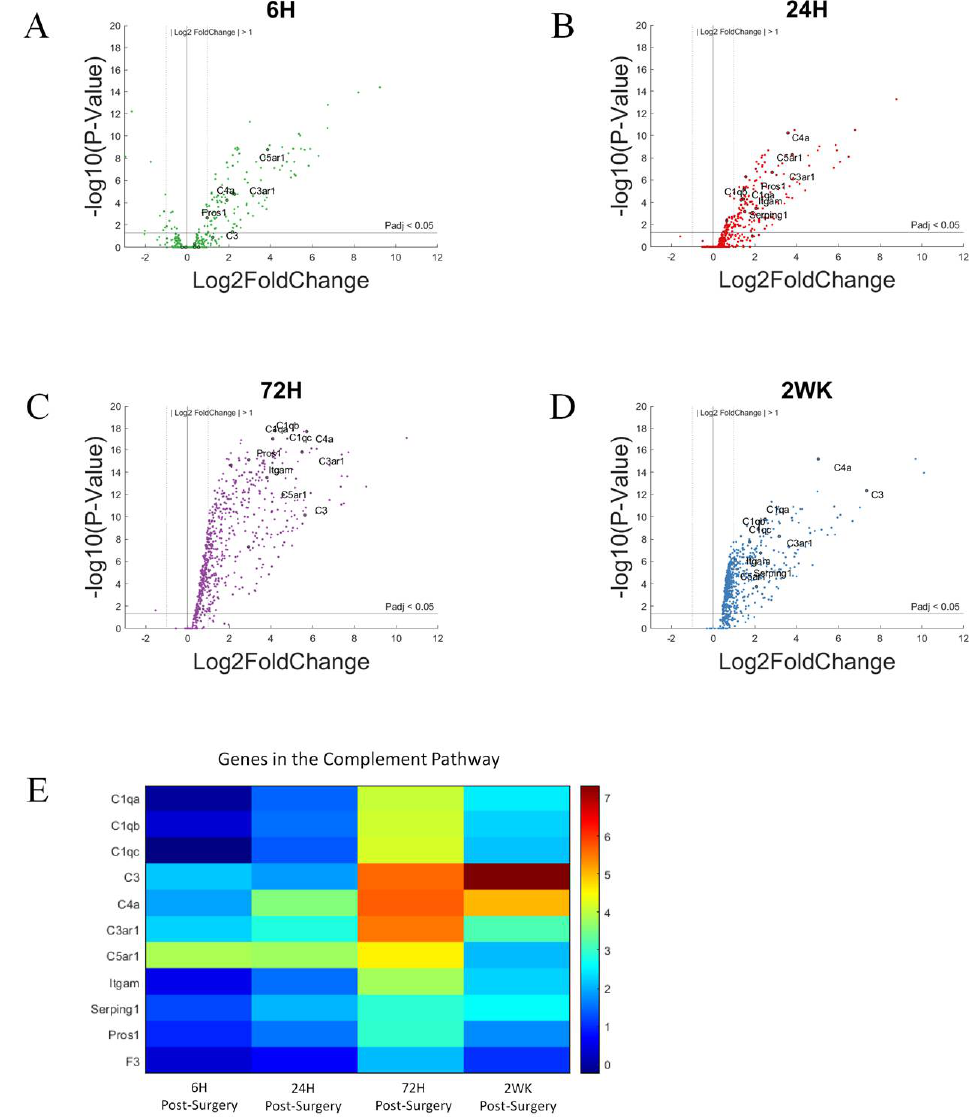
Figure 3. Differential expression of gene set involved in the complement pathway compared to NSCTR mice: ( A – D ) volcano plot with genes in the complement pathway shown in black circles. Top 10 genes by differential expression level and P adj < 0.05 are labeled. Each time point post-surgery is on a separate volcano plot. ( A ) =6-h, ( B ) =24-h, ( C ) =72-h, and ( D ) =2-weeks. Color in ( A – D ) corresponds to time post-surgery color coding in other figures. ( E ) heatmap showing differential expressions of genes of the complement system at each time point post-surgery compared to